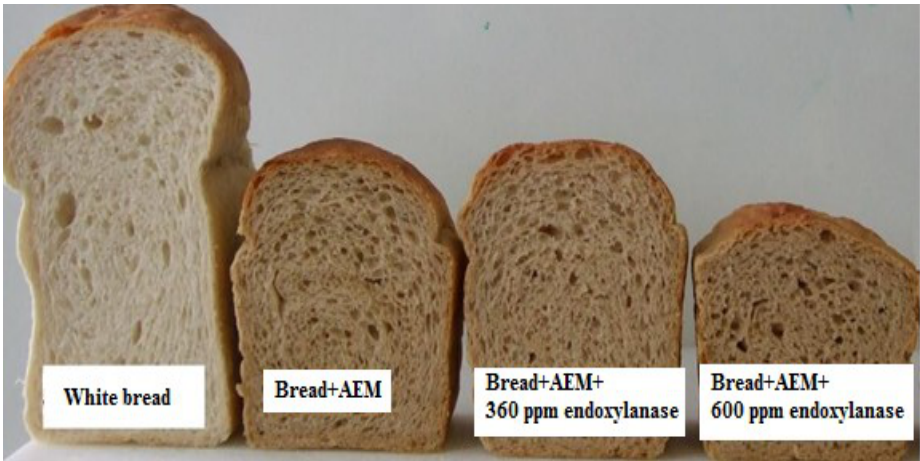
Figure 3. Bread crumb of white bread, bread + AEM, bread + AEM with 360 ppm of endoxylanase and bread + AEM with 600 ppm of